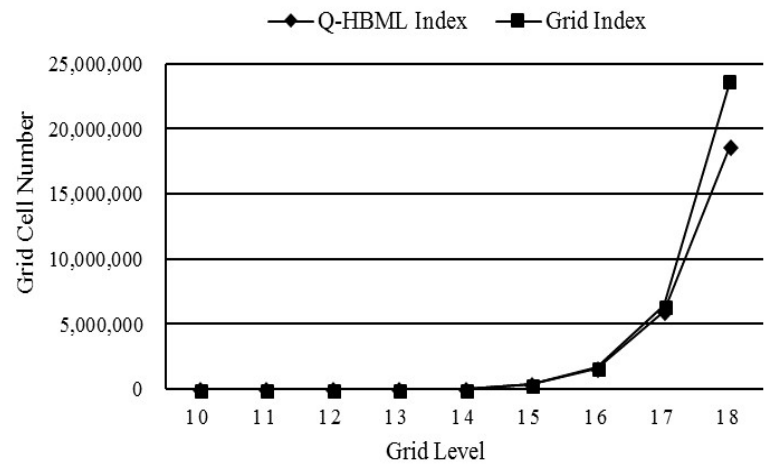
Figure 16. Grid cell construction number with Q-HBML index and regular grid index.